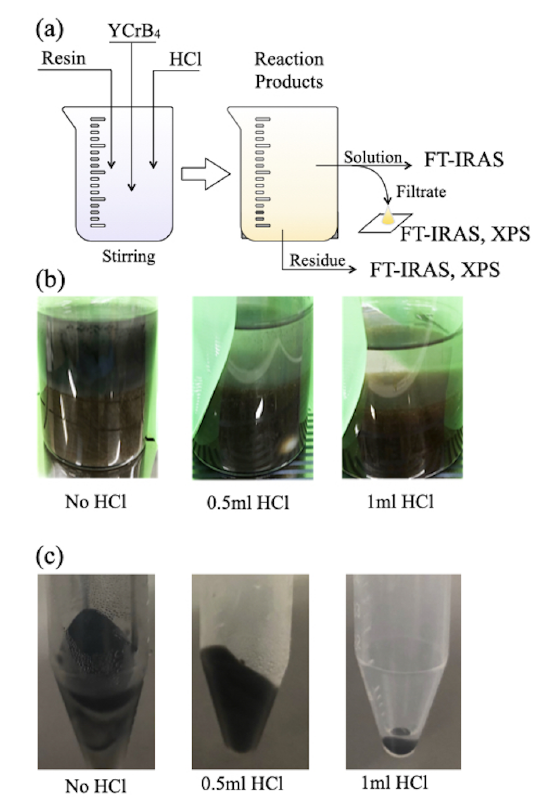
Figure 2. ( a ) Schematic drawing of the synthesis and characterization processes; ( b , c ) photos of ( b ) the reaction solutions and ( c ) the residue after three days of reaction with different amounts of hydrochloric